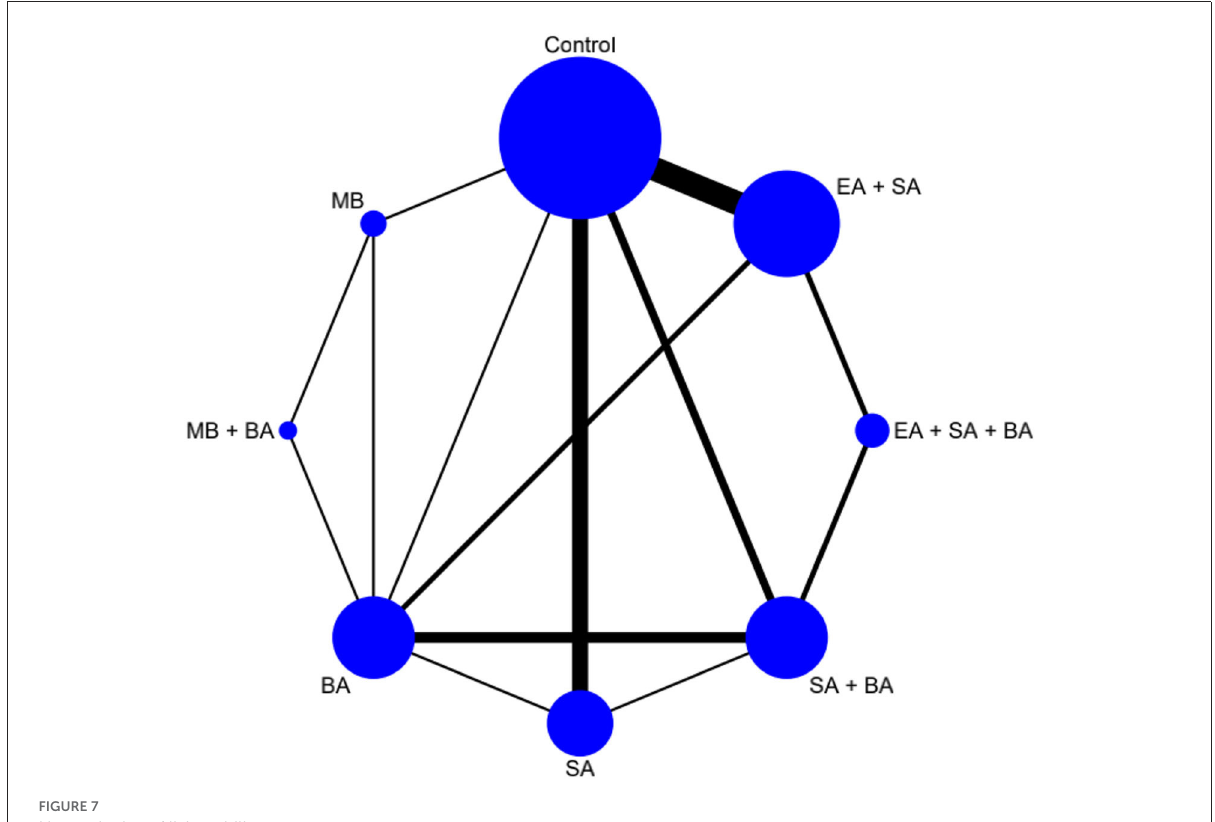
FIGURE7 Network plot of living ability.